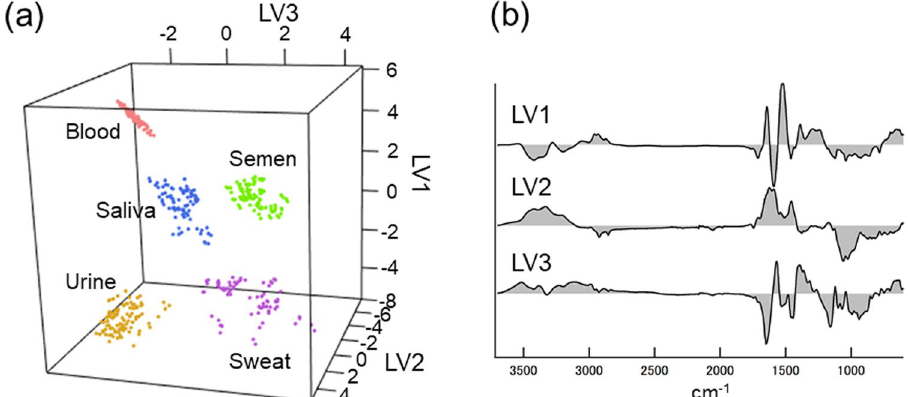
Figure 2. Five-class PLS-DA modeling for the ATR FT-IR spectra of fresh BFs. ( a ) A three-dimensional dot plot of the PLS-DA scores for the ATR FT-IR spectra of five BF types, peripheral blood (pink), saliva (blue), semen (light green), urine (yellow) and sweat (light purple), calculated by the five-class PLS-DA model for fresh BFs. ( b ) Weight loading vectors corresponding to the first three LVs in the five-class PLS-DA model.